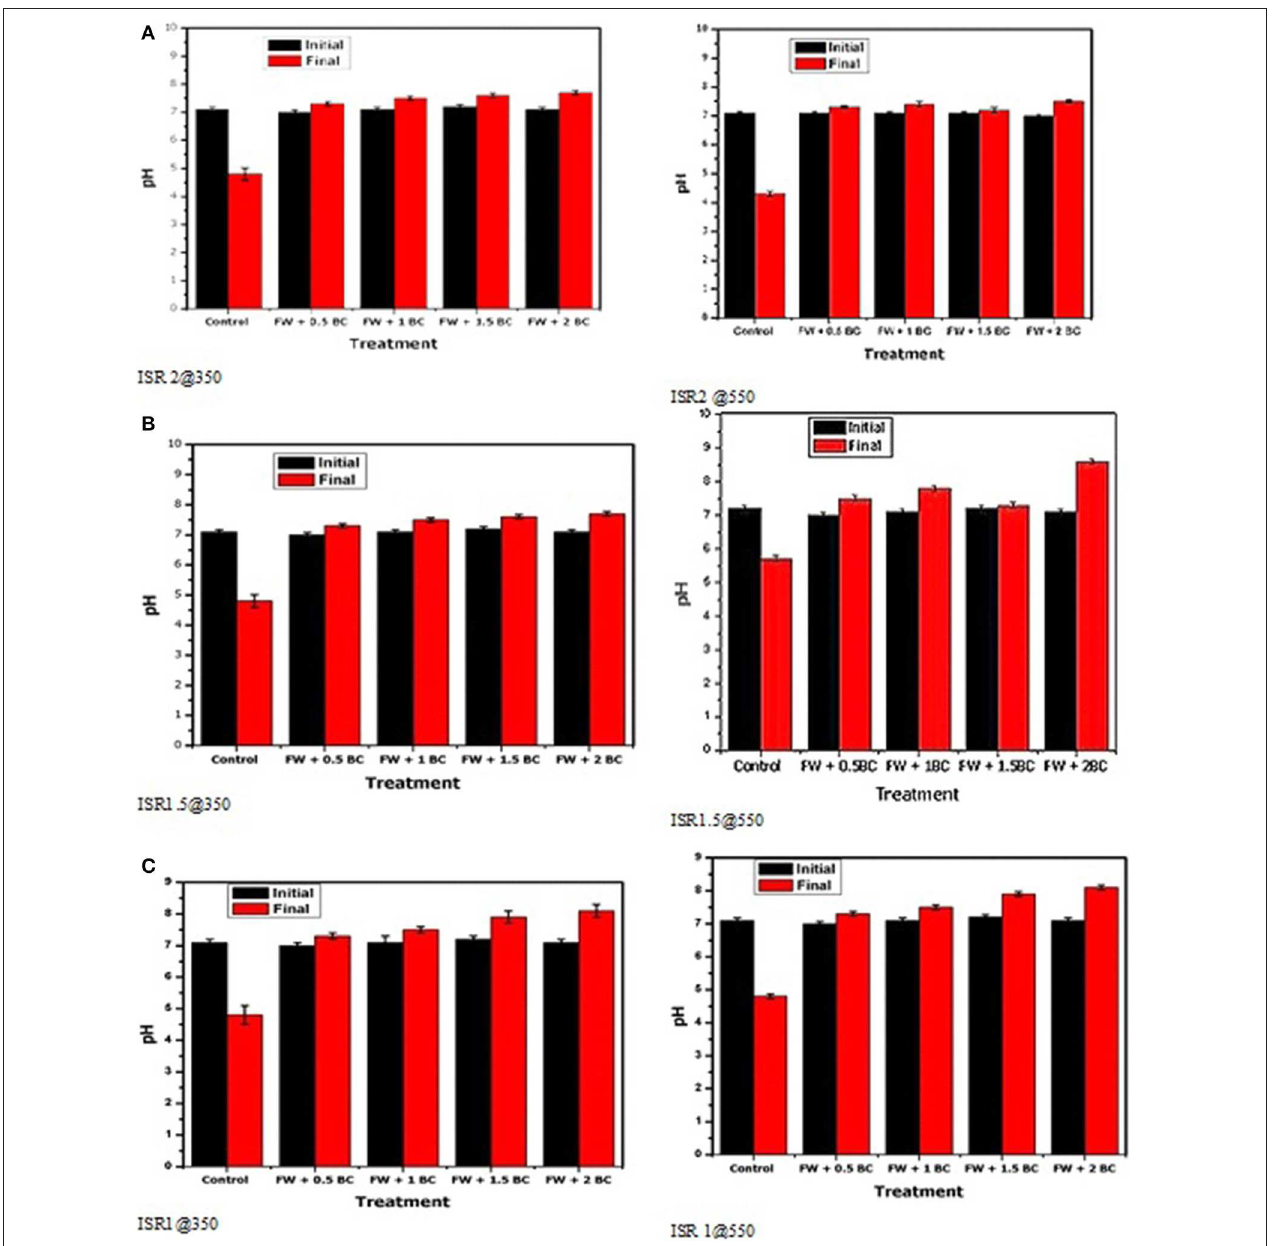
FIGURE 2 | Initial and final pH of the different AD treatments upon addition of different amounts of sludge biochar produced at: 350 ◦ C and 550 ◦ C, for ISR 2 (A) , ISR 1.5 (B) , ISR 1 (C) experiments. Averages of triplicate measurements are displayed, and error bars correspond to standard